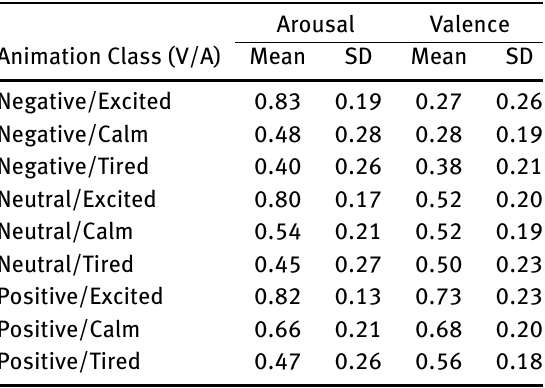
Table 5: Descriptive statistics by animation class of valence/arousal levels combinations (also visualized in Figure